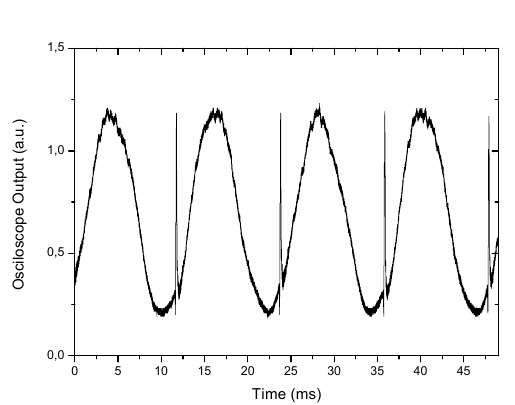
Figure 9. Output signal in oscilloscope for true pseudo-heterodyne.